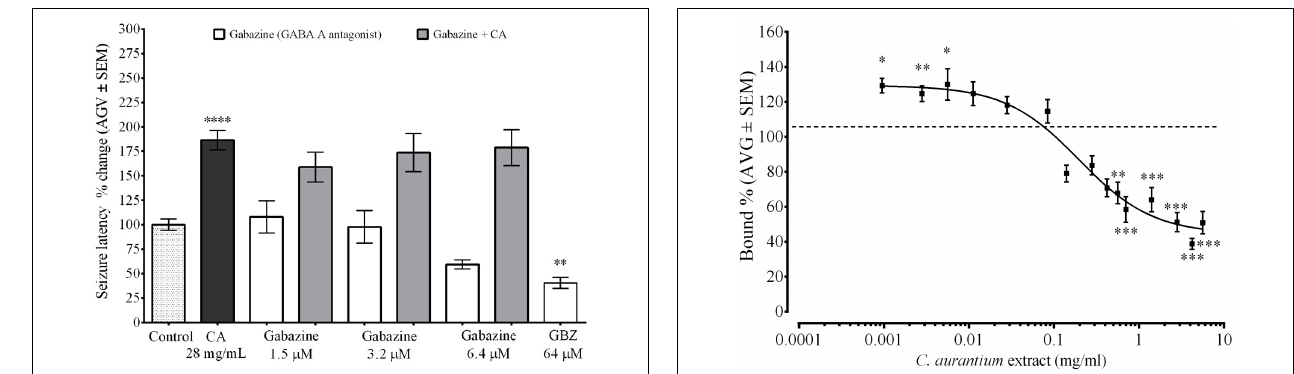
to 159 ± 15% (GBZ 1.5 μ M), 173 ± 20% (GBZ 3.2 μ M), and